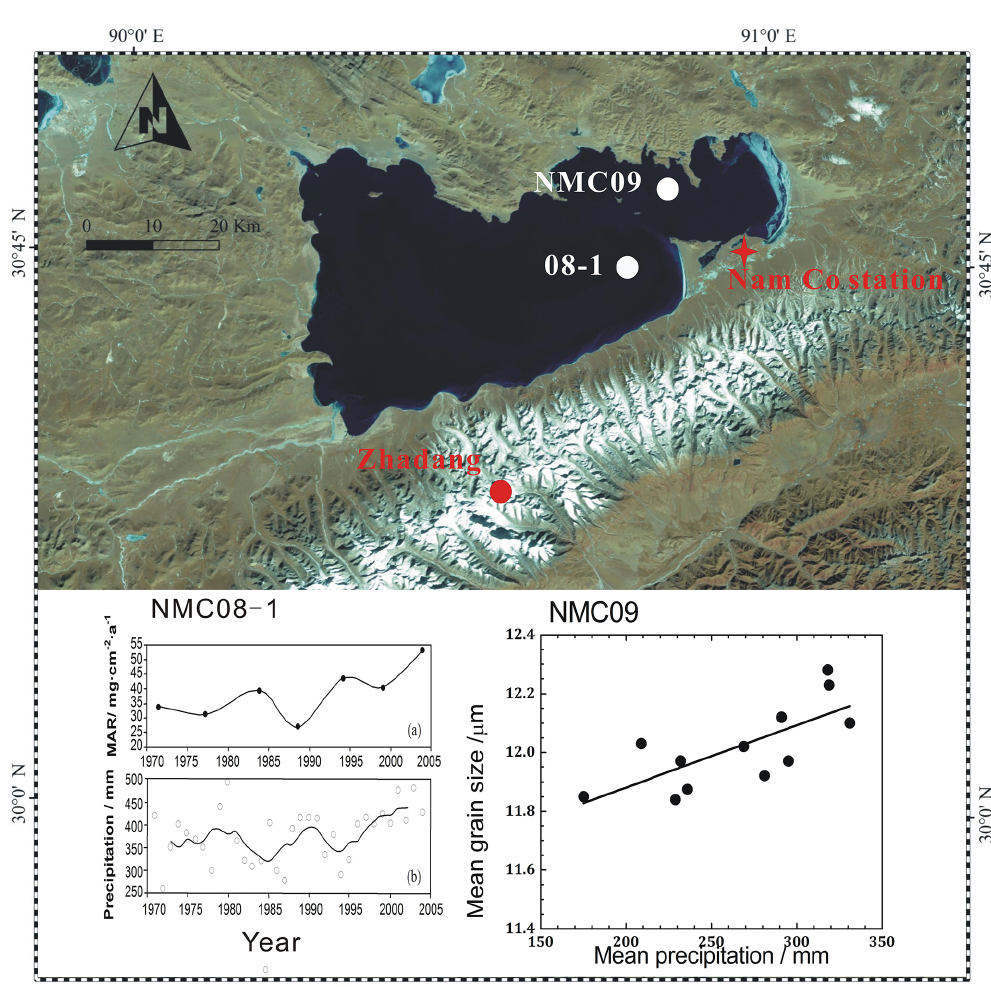
Figure 5. Similar variations in precipitation and mass accumulation rates (a) (Wang et al., 2011) and significant relationships between mean precipitation and mean grain size (b) (Li et al., 2014) in the Nam Co Lake cores.